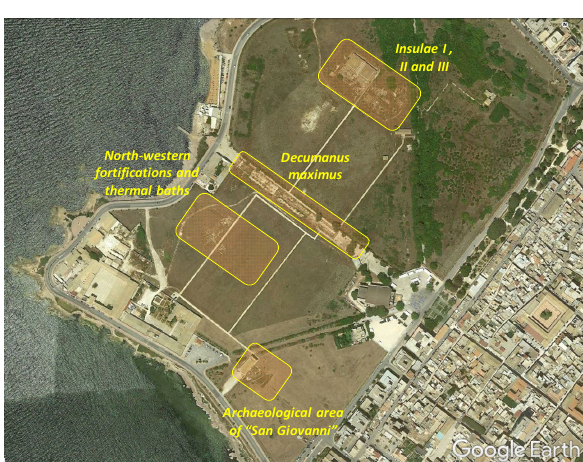
Figure 2. The areas of the UAV surveys (from Google Earth©).